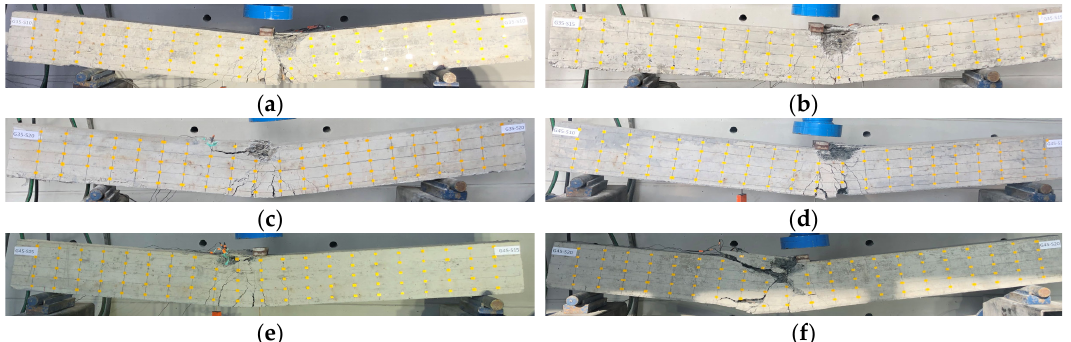
Figure 4. Crack pattern and failure modes. ( a ) G35S10, ( b ) G35S15, ( c ) G35S20, ( d ) G45S10, ( e ) G45S15 and ( f ) G45S20.